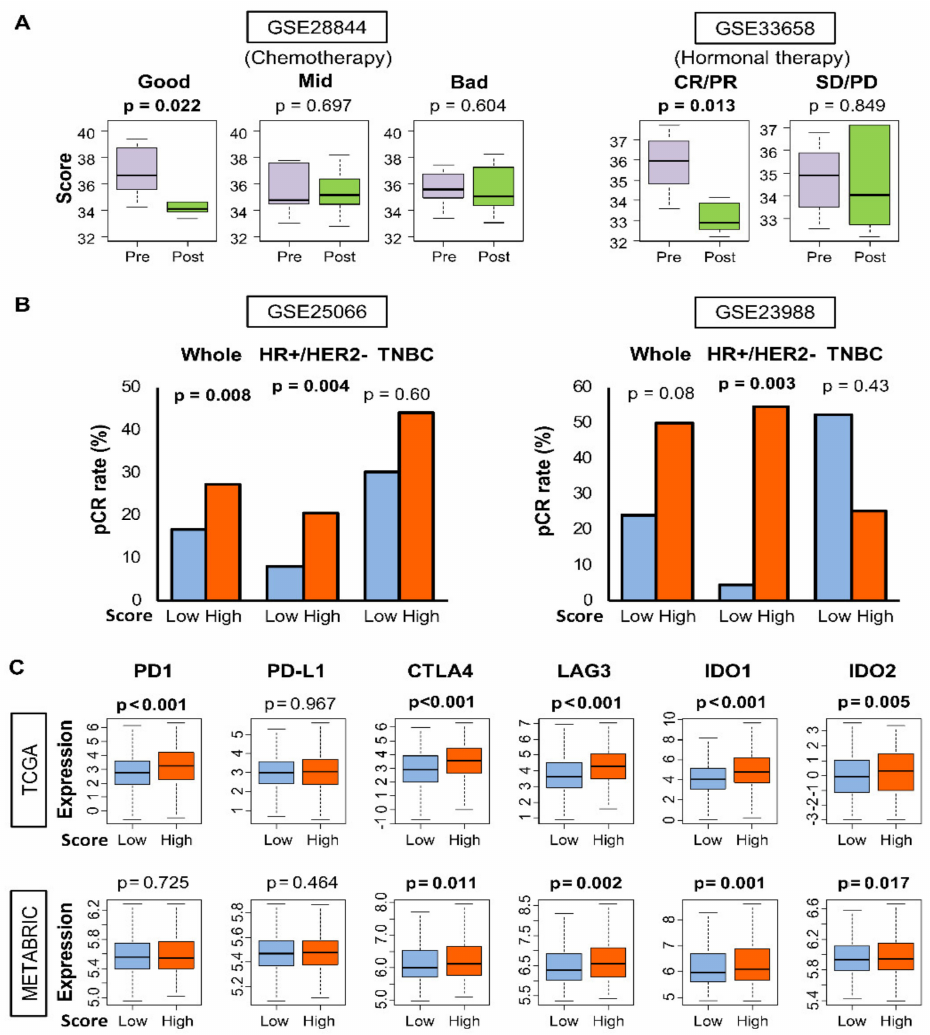
Figure 5. Relationships between response to therapy and the gene score. The examined cohorts are indicated. ( A ) Boxplots show the scores of pre- and post-neoadjuvant chemotherapy tumors of GSE28844 cohorts, and of pre- and post-therapy tumors of GSE33658 cohort in which neoadjuvant hormonal therapy was used. For GSE28844, response categories are as per Miller–Payne criteria. RECIST criteria are used for GSE33658 ( PD , partial disease; SD , stable disease; PR , partial response; CR , complete response). Standard t tests were used to determine p values. All boxplots are of Tukey type and the boxes depict medians and inter-quartile ranges. ( B ) Barplots show the pathologic complete response ( pCR ) rates in high- and low-score groups of GSE25066 ( n = 508) and GSE23988 ( n = 61). Fisher’s exact test was used to determine p values. The one-third percentile value of the 4-gene score was used to classify tumors into low and high groups. ( C ) Comparisons of gene expression (log 2 transcripts per million) of immune response genes in tumors of high or low 4-gene scores in both TCGA and METABRIC cohorts. Boxplots of expression of immune response genes in tumors with high and low 4-gene scores. The one-third percentile value of the 4-gene score was used to classify tumors into low and high groups. All boxplots are of Tukey type and the boxes depict medians and inter-quartile ranges. The depicted p values were calculated with standard t tests. CTLA4 , cytotoxic T-lymphocyte-associated protein 4; IDO1 / 2 , indoleamine dioxygenase 1 / 2; LAG3 , lymphocyte activation gene 3; PD-1 , programmed death-1; PD-L1 , (programmed death ligand